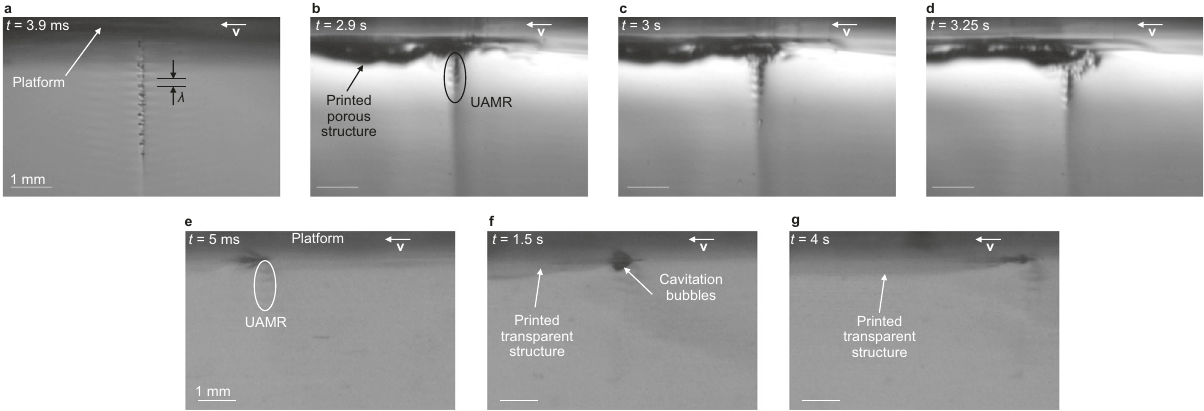
Fig. 3 Porous and transparent printing observation of UAMR on the platform during insonication of the build chamber. a – d Porous printing progress in progressive times. v = 300 mm/min, and h = 30 mm e – g Transparent printing progress in progressive times, v = 240 mm/min, Power = 20 W, DC = 50%.(other experimental conditions are the same as Fig. 2). (UAMR: ultra-active